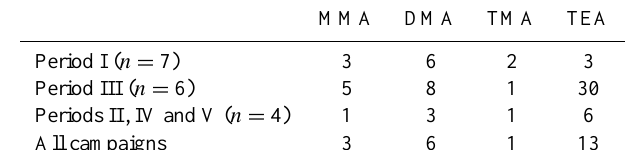
Table 1. Concentrations (ngm − 3 ) of alkyl amines as measured by 1 H-NMR spectra.